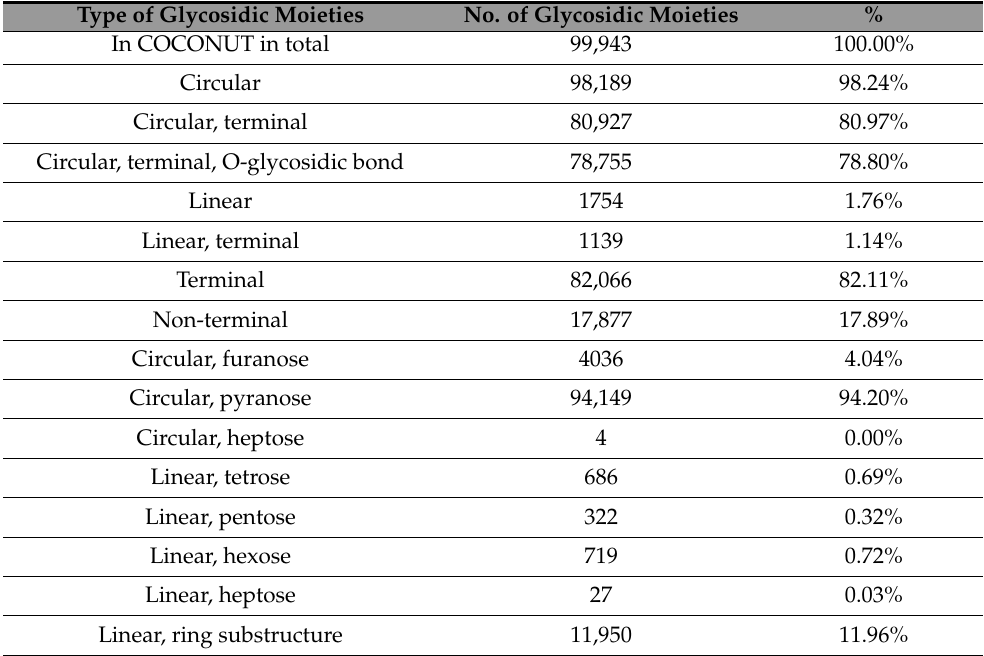
Table 2. Proportions of different types of glycosidic moieties detected in